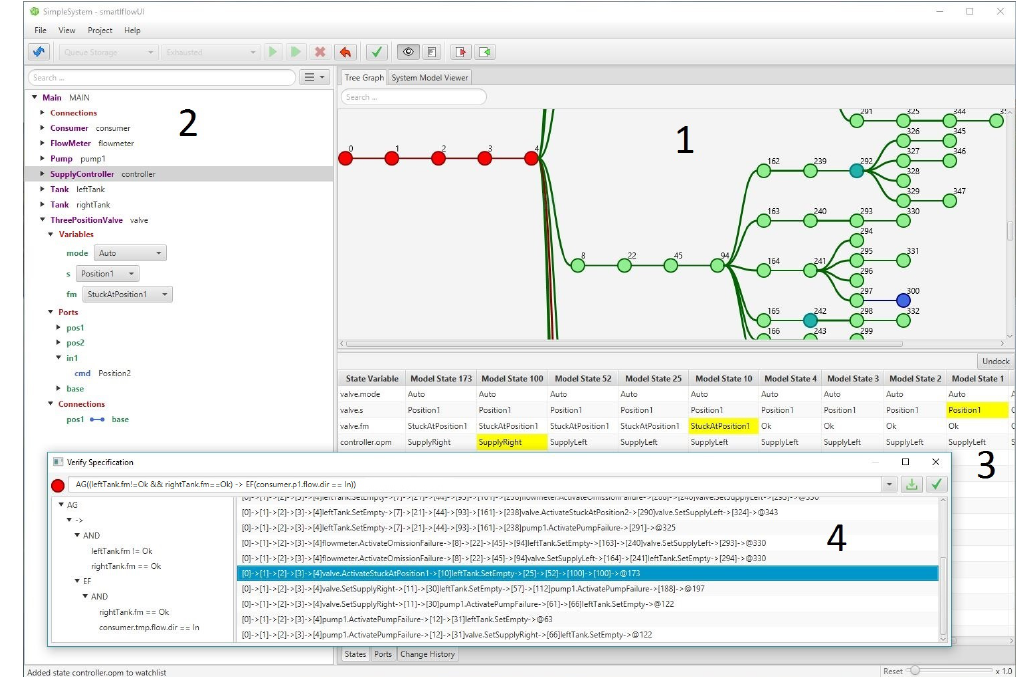
Figure 5. smartIflow simulation